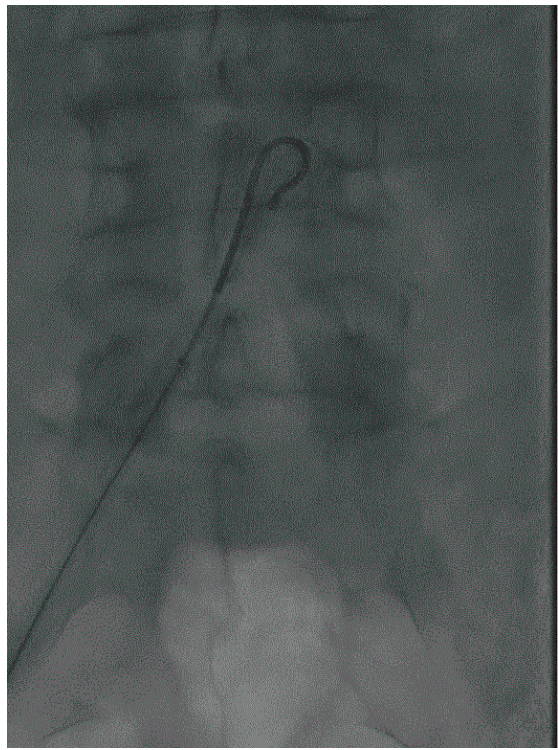
Figure 3. Crossover technique. 6F-45 cm sheath, UF catheter and hydrophilic guidewire are associated to realize the